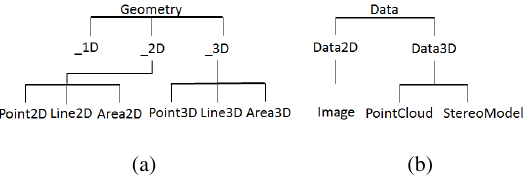
Figure . (a) Class hierarchy of geometry (b) data